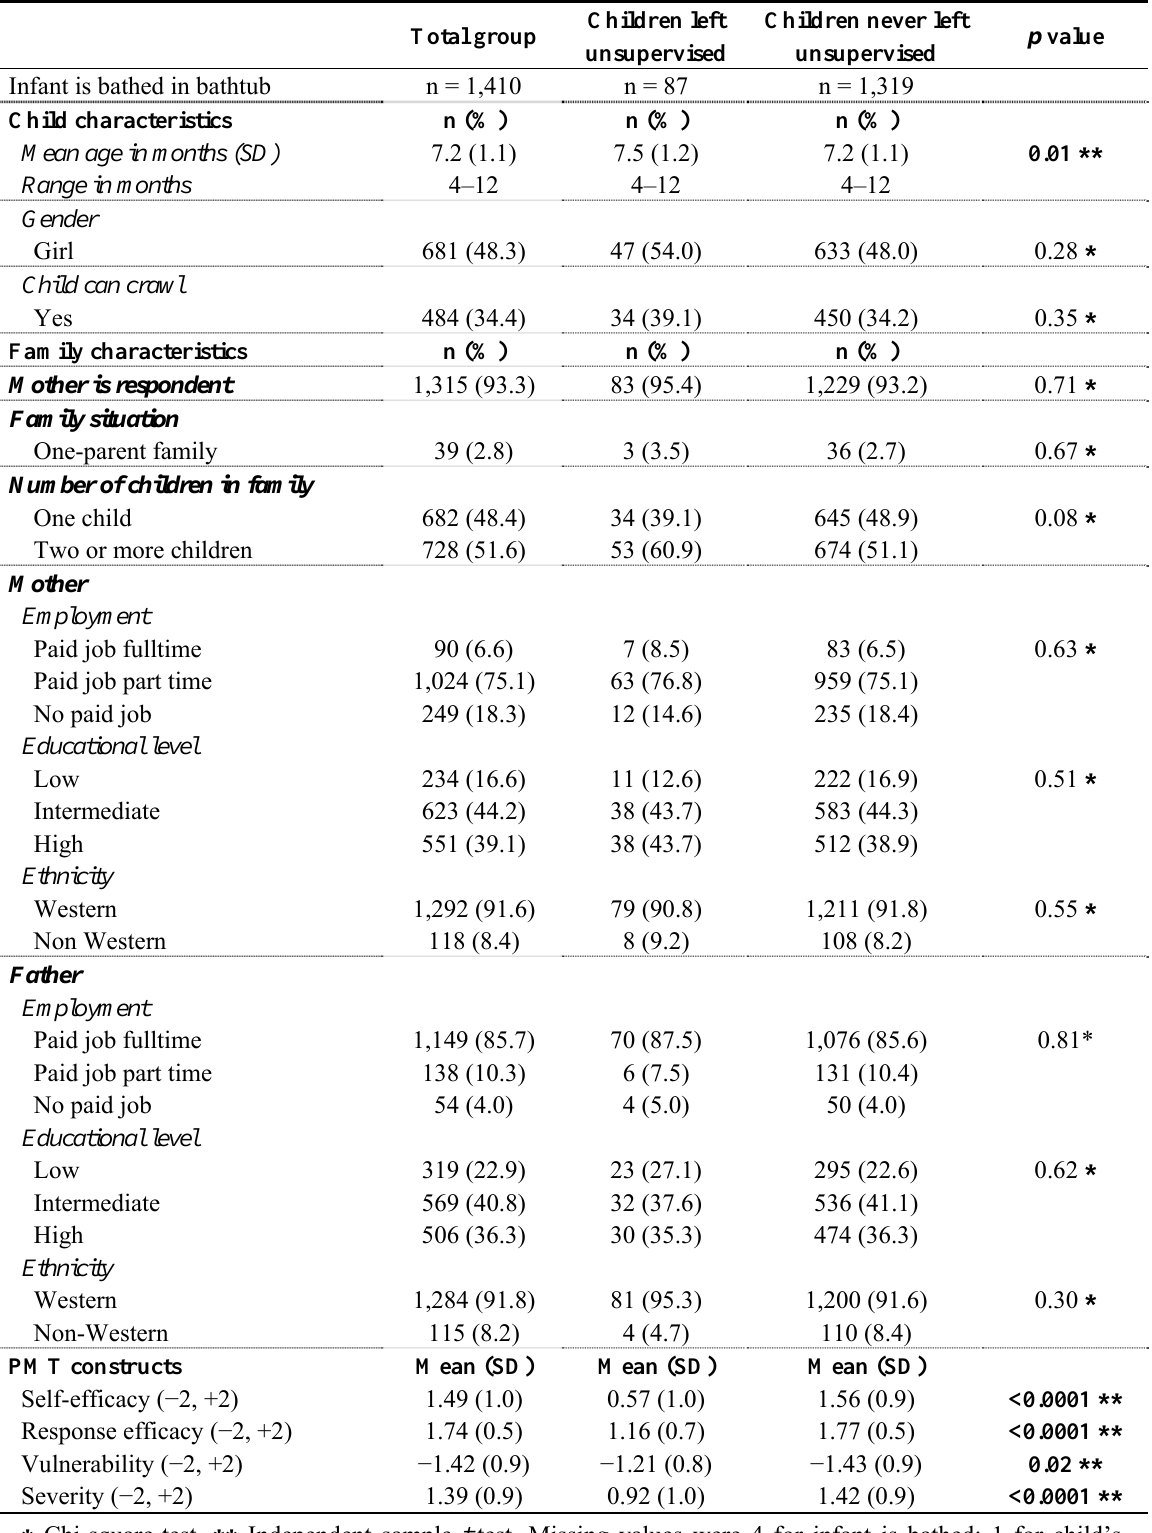
Table 1. Child and family characteristics and PMT constructs of supervision of infants in bathtubs (n =